Question: In one sentence, what is this figure communicating?
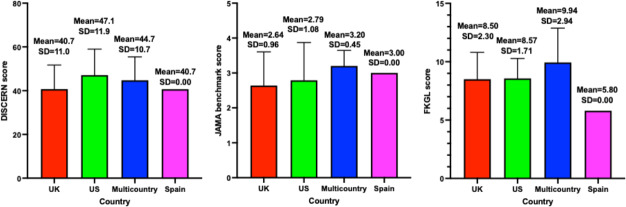
Answer: Graphical representation of the means and SDs of DISCERN, Journal of the American Medical Association (JAMA) benchmark, and Flesch-Kincaid Grade Level (FKGL) scores based on the origin countries of the websites.